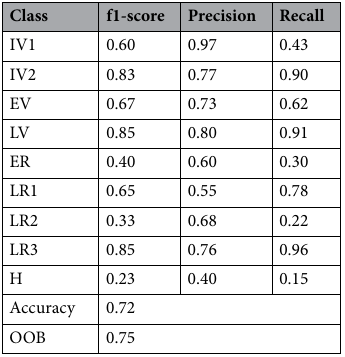
Table 3. Classification metrics when testing for spatial transferability using all the